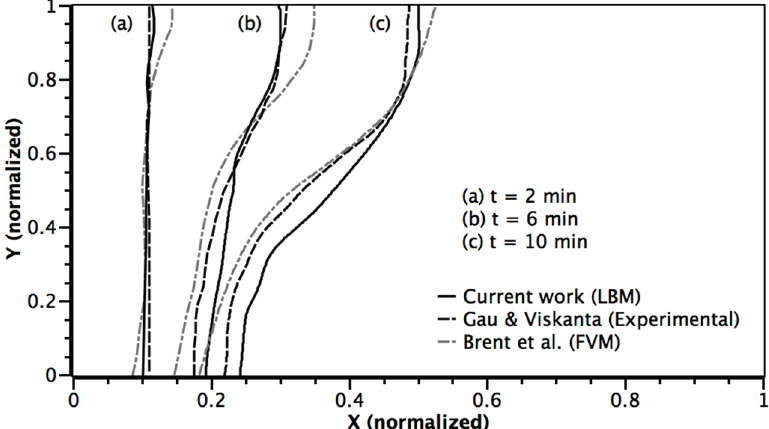
Figure 4. Position and shape of the melting front at selected times: ( a ) 2 t = min, ( b ) 6 min and ( c ) 10 min compared to [30,31].